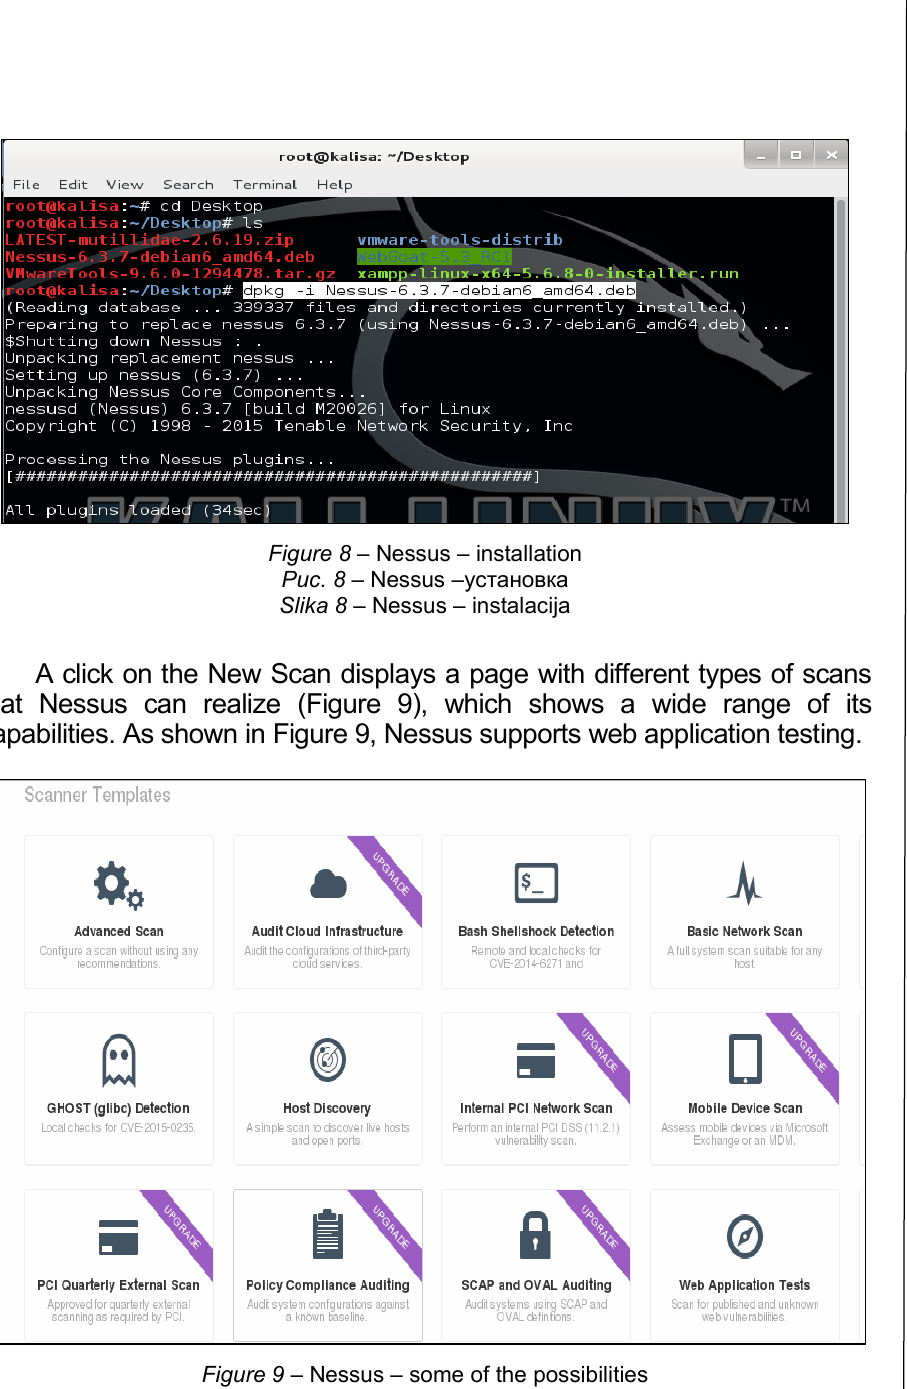
Figure 9 – Nessus – some of the possibilities Рис . 9 – Nessus – некоторые возможности Slika 9 – Nessus – neke od mogu ć